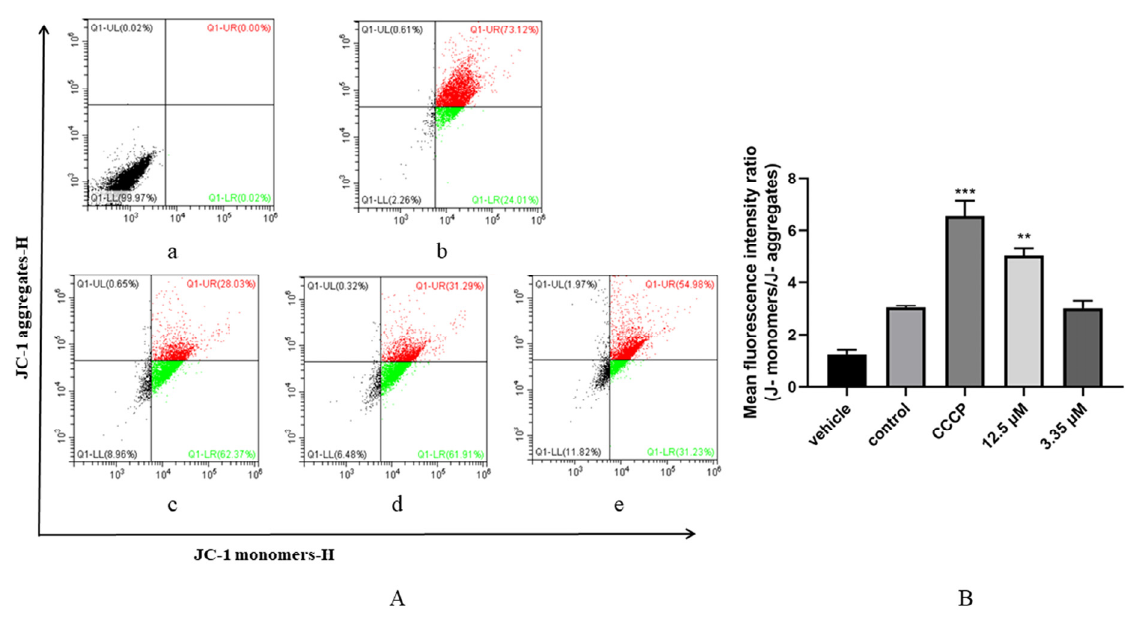
Figure 7. The change in T. gondii mitochondrial membrane potential. ( A ): Changes in red and green fluorescence were used to evaluate the mitochondrial membrane potential of extracellular T. gondii . The proportion of tachyzoites in quadrant 2 (Q1 − UR) represents the degree of depolarization of mitochondrial membranes of T. gondii . ( a ) extracellular tachyzoites were treated with PBS, ( b ) extracellular tachyzoites were added using a JC − 1 probe with PBS, ( c ) extracellular tachyzoites were treated with CCCP as positive control, ( d , e ) tachyzoites were treated with artemether of 12.5 µ M and 3.35 µ M, respectively. ( B ): Statistical analysis of fluorescence intensity. The data were represented by mean ± SD of three experiments, and each experiment was conducted in triplicate, and 3 technical replicates were included in each experiment. Significant differences compared to the control are indicated by ** p < 0.01, *** p < 0.001.